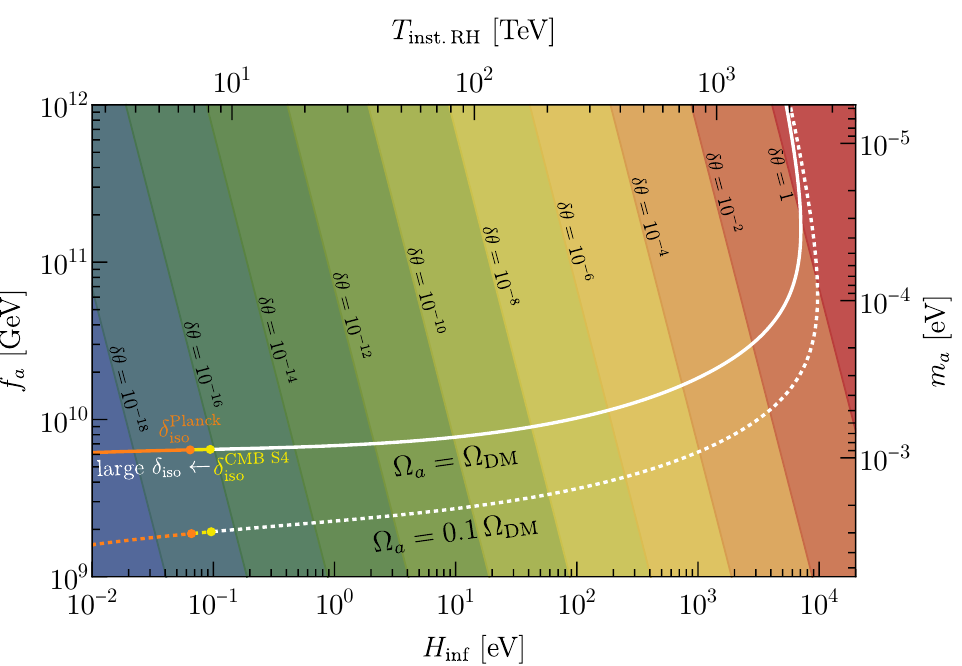
Figure 2 . Parameter space leading to an axion abundance (cid:10) a equal to the observed dark matter abundance (cid:10) dm (solid white line). For reference, we also show the line for (cid:10) a = 0 : 1(cid:10) DM (white dashed). The axion abundance in the misalignment mechanism is set by f a and the displacement (cid:14)(cid:18) of the axion (cid:12)eld from the top of its potential as it starts oscillating. Contours of (cid:14)(cid:18) are shown with coloured lines. In our setup, where the typical size of (cid:14)(cid:18) is set by the spread of the axion (cid:12)eld around its minimum during in(cid:13)ation, we trade (cid:14)(cid:18) for the Hubble rate during in(cid:13)ation H inf (shown on the lower horizontal axis). For reference, we show on the upper horizontal axis the temperature implied by a given H inf for instantaneous reheating. Along the white lines, we colour in orange (respectively yellow) the parameter space excluded by Planck [62] (respectively testable by CMB S4 [63]) searches of isocurvature (cid:13)uctuations ((cid:12)gure adapted from